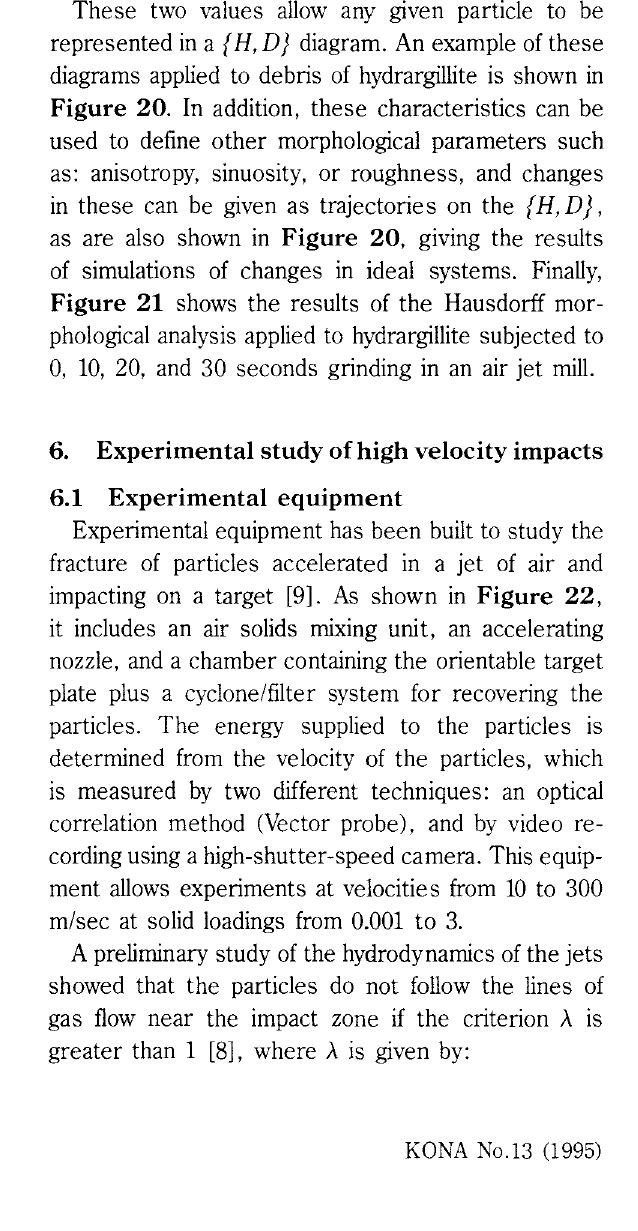
Fig. 18 SEM photo of a particle of hydrargillite